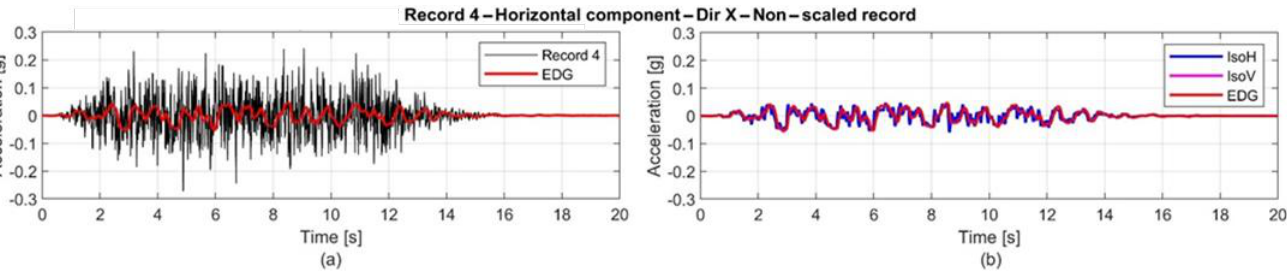
Figure 4. Horizontal acceleration time history results for non-scaled Record 4—direction “X”. ( a ) Record and EDG response comparison; ( b ) System response by isolation level.